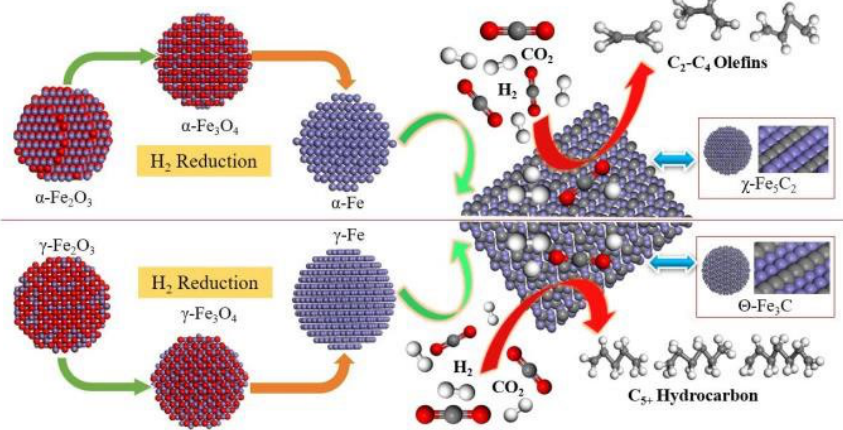
Figure 11. Scheme of the structure– performance relationship of α -Fe 2 O 3 and γ -Fe 2 O 3 catalysts for CO 2 hydrogenation during activation and reaction processes. Reprinted with permission from ref. [41]. Copyright 2018 John Wiley and